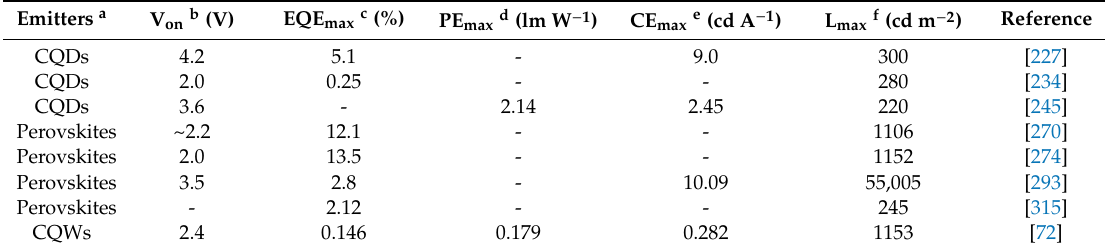
Table 1. Performances for representative impurity-doped nanocrystal